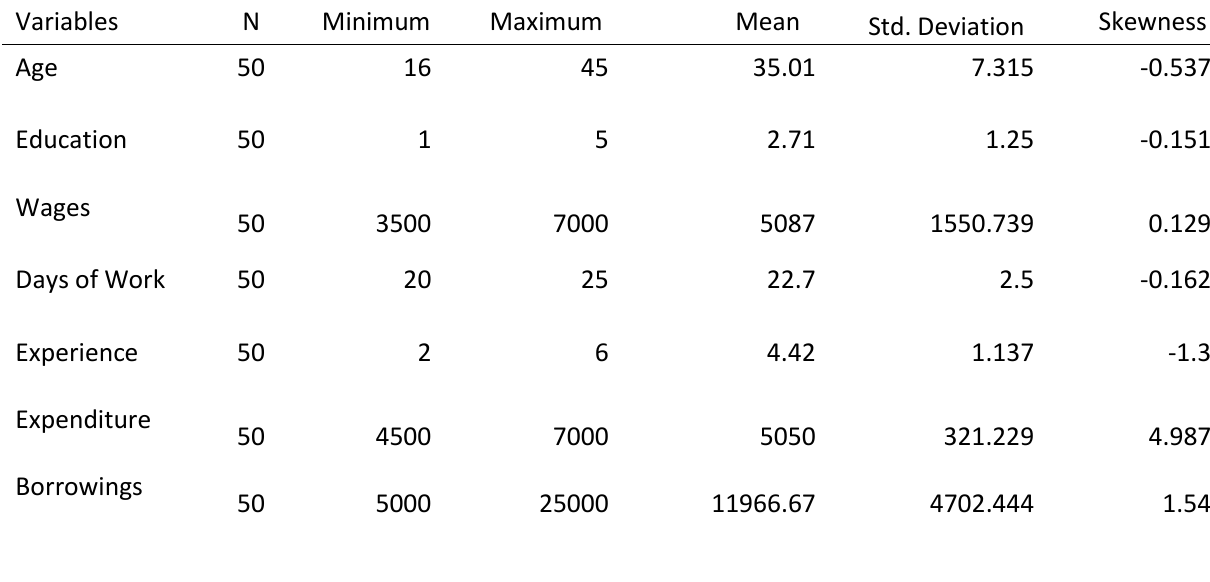
Table 2: Descriptive Statistical Results on Socio-Economic Conditions of Sample